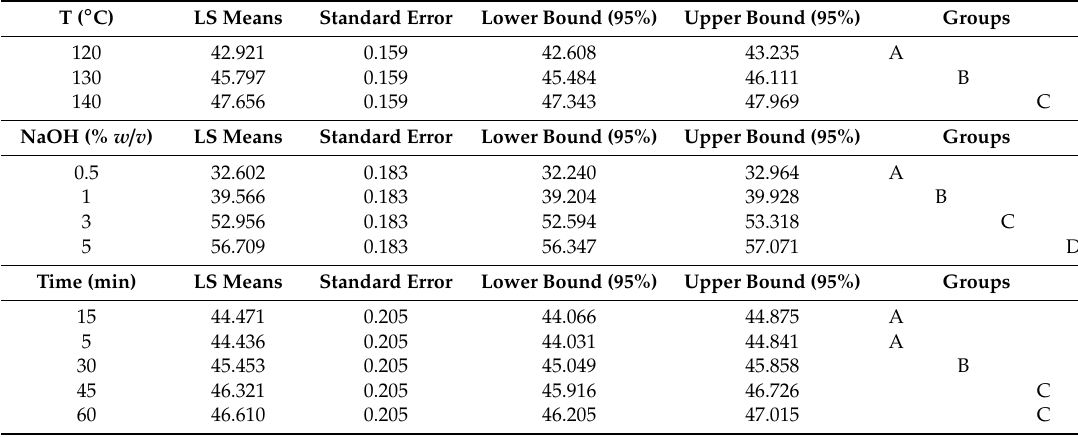
Table A1. Tukey’s HSD test results for the MW-A pretreatment in water medium in relation to the TRS yield (%). Analysis of the di ff erences between the categories with a confidence interval of 95% for: temperature (top), NaOH concentration (center) and time